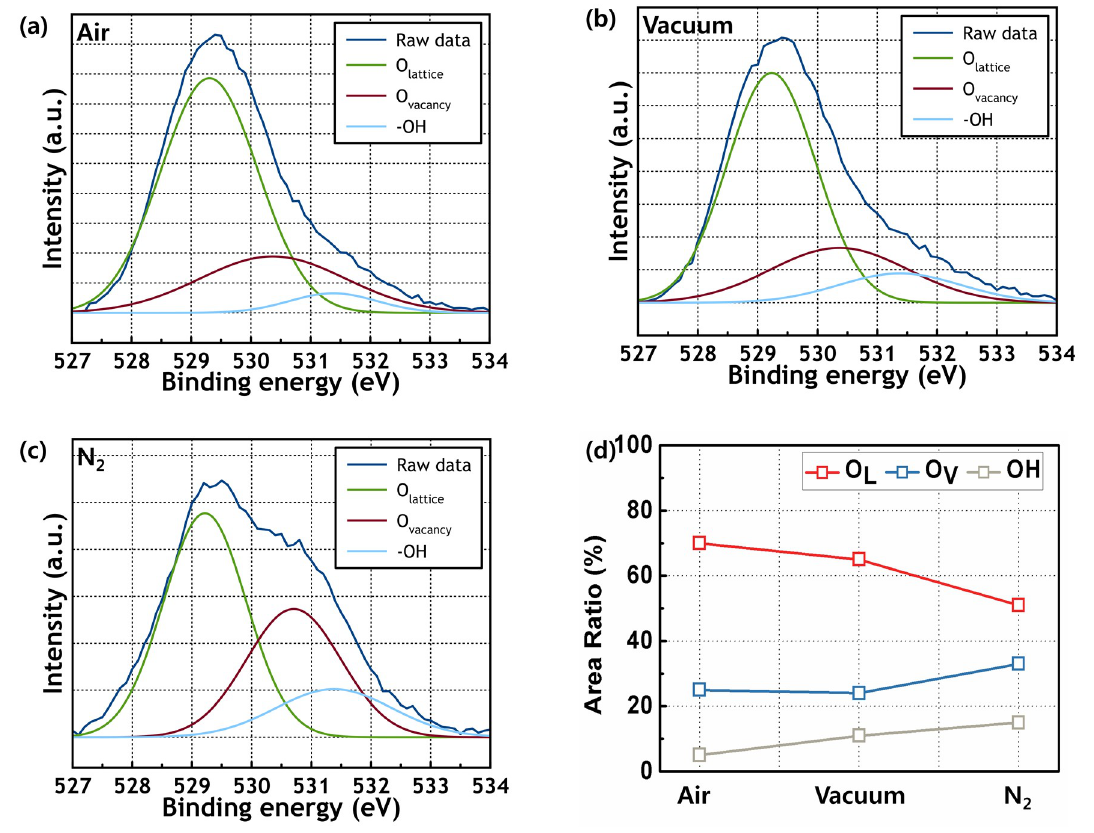
Figure 3. O 1s XPS spectra of ZrO 2 films annealed in ( a ) air, ( b ) vacuum, and ( c ) N 2. And ( d ) proportions of oxygen lattice, vacancy, and hydroxyl groups of fabricated films.